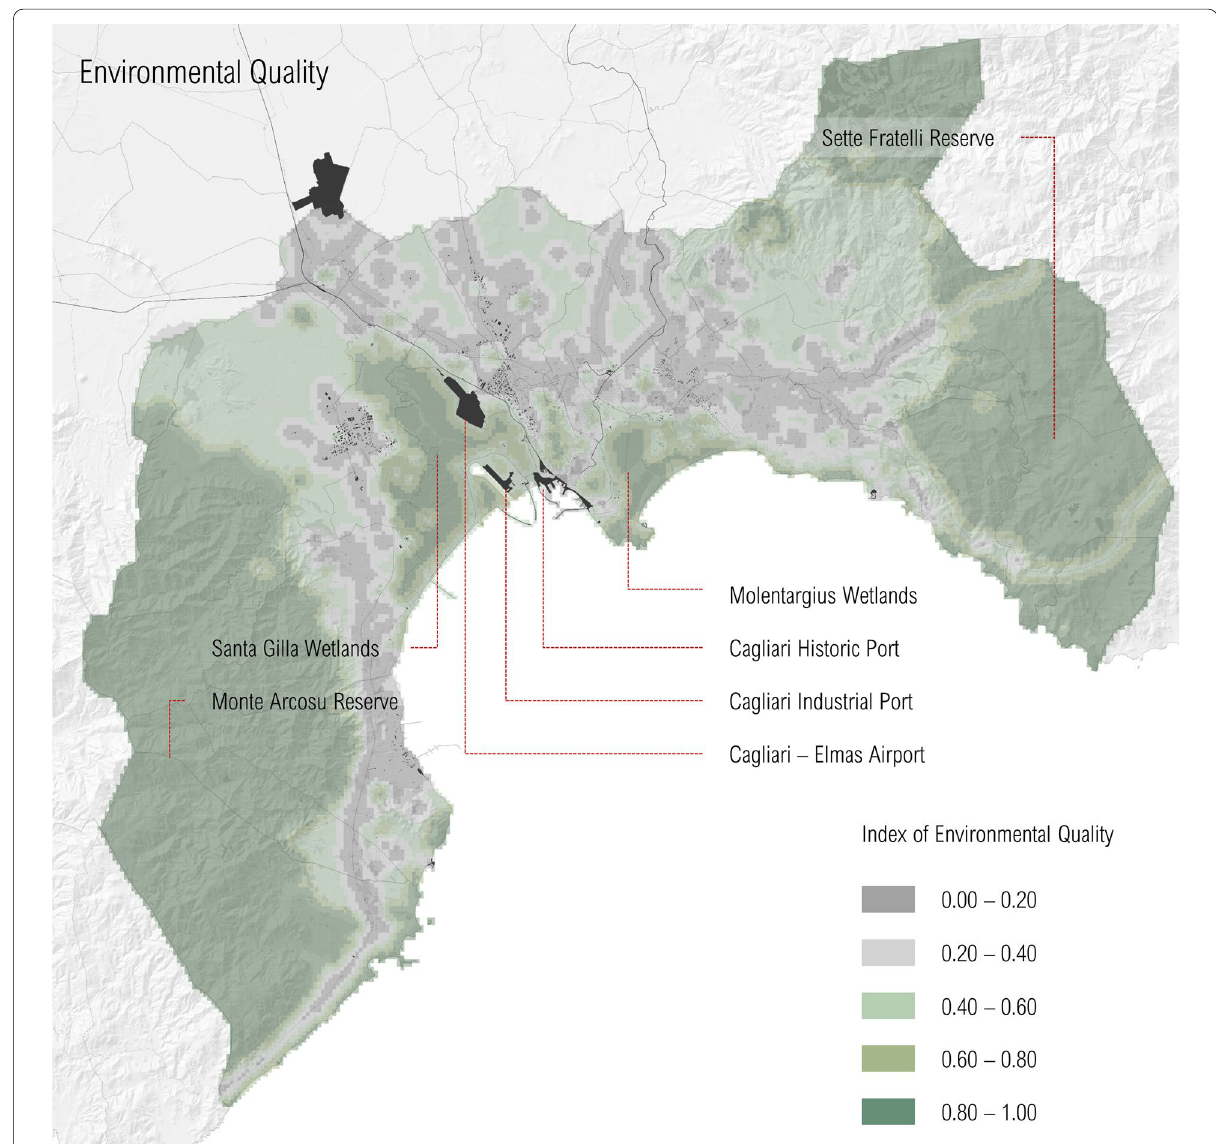
Fig. 12 Distribution of the values of the Index of Environmental Quality (I_EQ) in the Metropolitan City of